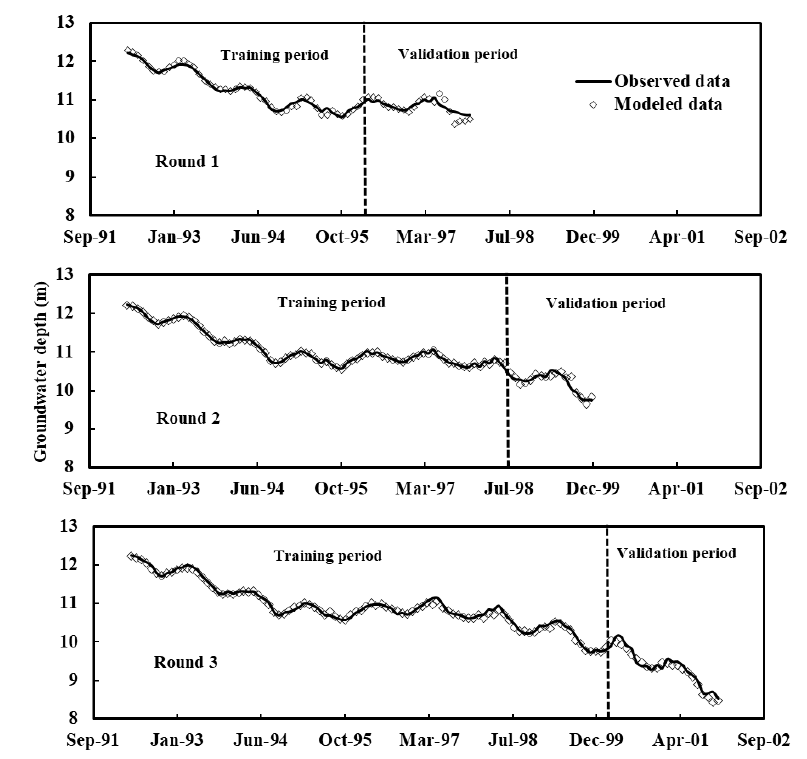
Figure 6. Observed and modeled groundwater levels for well BN-1A at different validation rounds.